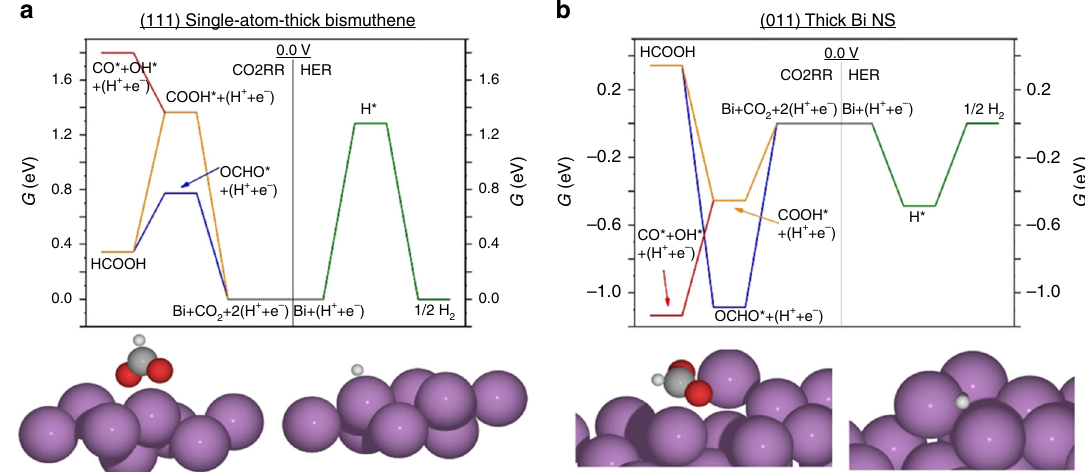
Fig. 5 DFT calculations. a , b Calculated free energy diagrams for CO2RR and HER on (111) single-atom-thick Bismuthene ( a ) and (011) thick Bi nanosheets ( b ) at 0.0 V. HER is represented in green, and CO2RR through OCHO* and COOH* are represented in blue and orange, respectively. The state of CO* + OH* is represented in red. The insets below the diagrams depict the adsorption structures of OCHO* and H*. Violet, red, gray, and white spheres in the insets represent Bi, O, C, and H atoms,